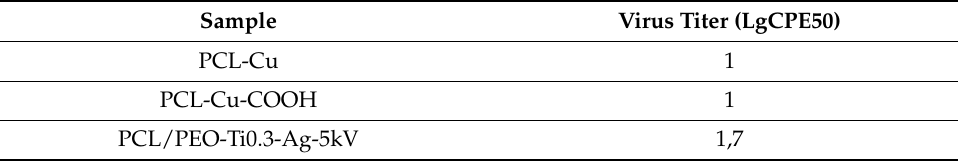
Figure 12. MTT assay of VeroE6 cells infected with SARS-CoV-2 (after incubation with samples), showing an antiviral activity of PCL-ref, PCL-Cu, PCL-Cu-COOH and PCL/PEO-Ti0.3-Ag-5kv materials and controls of the intact SARS-CoV-2. Table 2. The titers of the SARS-CoV-2 virus